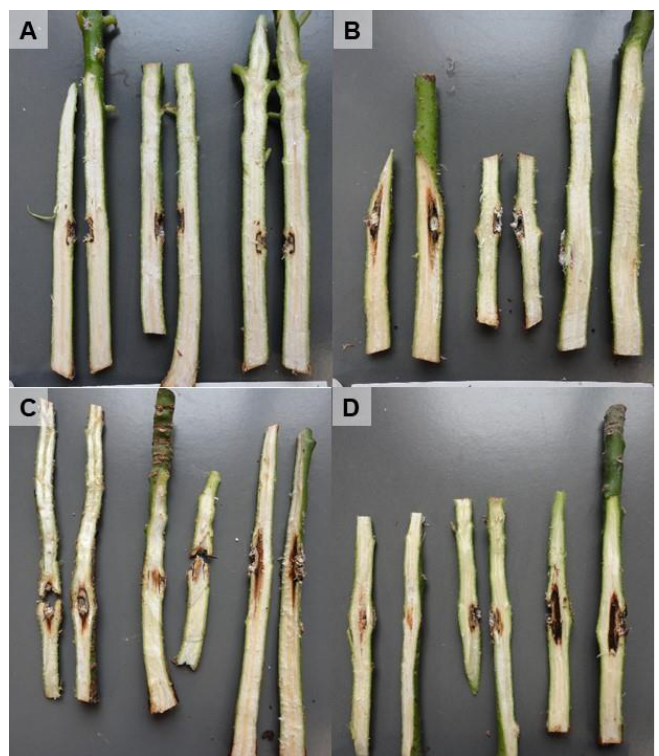
Figure 6. Internal symptoms in Topa Topa avocado seedlings 6 months after inoculation. Plants were inoculated by inserting a mycelial plug in a wound made in the stem at 5 cm from the ground. All plants shown in the figure were bagged for 10 d after inoculation. ( A ), negative control (plants inoculated with a fungus-free agar fragment); plants inoculated with isolates: ( B ), Neofusicoccum luteum B153; ( C ), N. parvum B156; and ( D ), Lasiodiplodia brasiliensis B161.